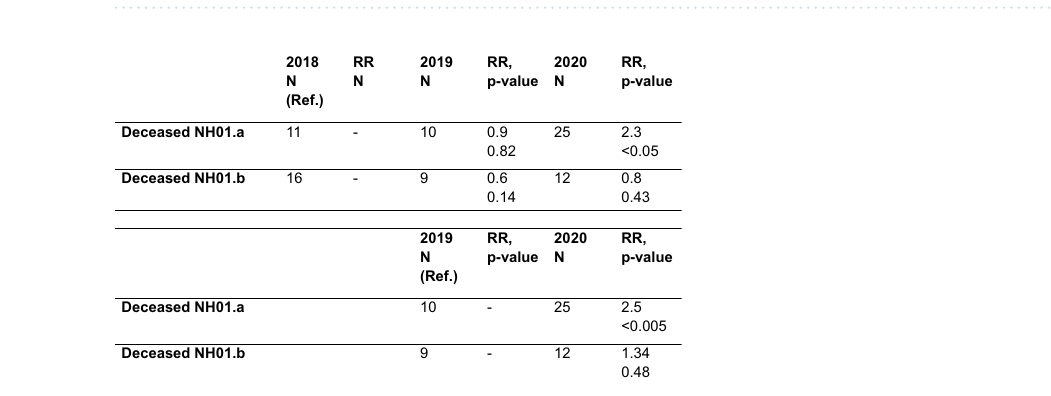
Figure 11. Mortality analysis among residents from 2018 until 2020. ( a ) Mortality among residents of NH01.a and NH01.b from 01/01 to 30/04 of the years 2018–2020. Data are given in (%). ( b ) Mortality of NH01.A residents in March and April for the years 2018, 2019 and 2020. Data are given in (%).